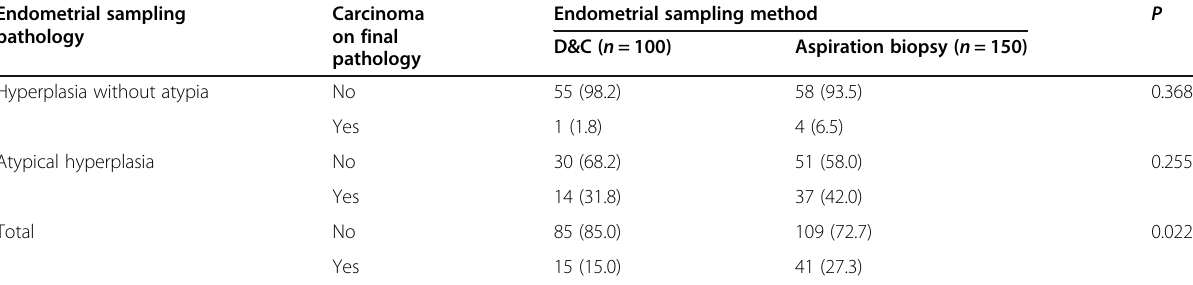
Table 5 Comparison of final pathological carcinoma risks based on endometrial sampling methods Endometrial sampling